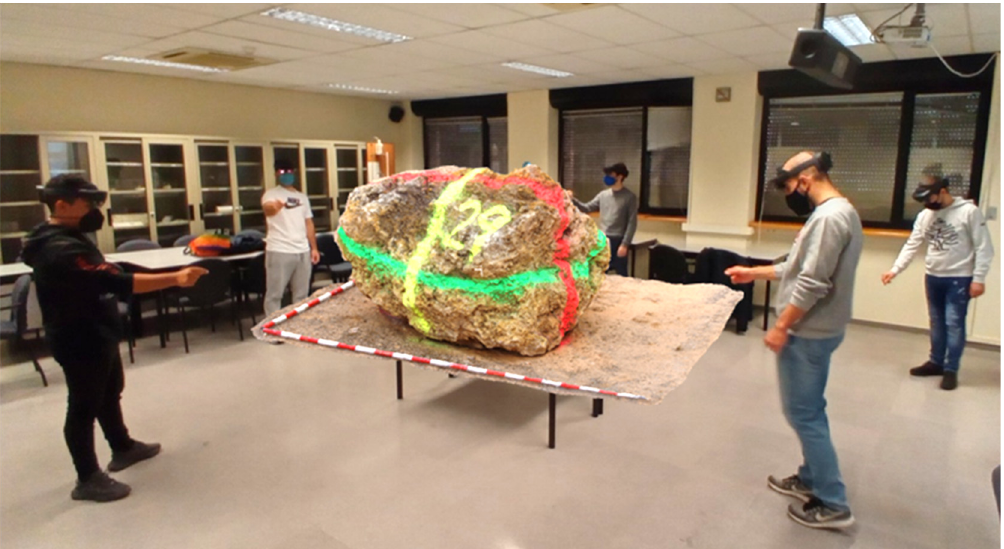
Figure 15. In the classroom, inspecting a 1:1 scale hologram of the limestone block number 29 used in the R&D project GeoRisk [46]. The model was built by means of a circular terrestrial photogrammetry survey [10,56] (pictures courtesy of GeoRisk project).